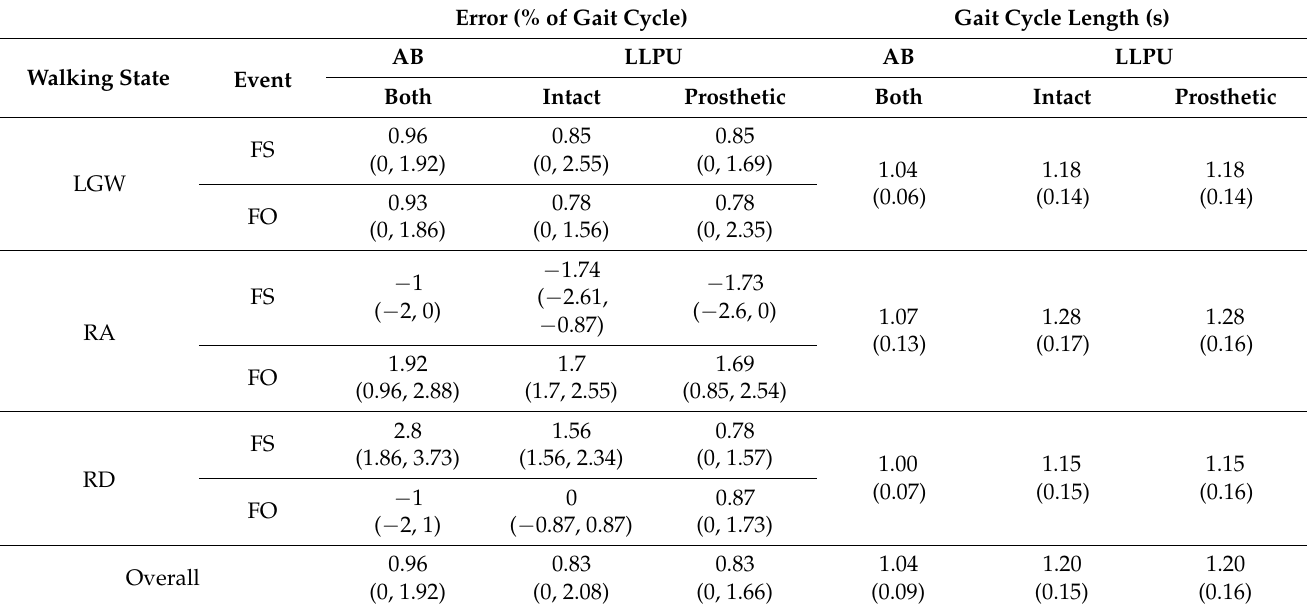
Table 4. Temporal error (median (IQR1, IQR3)) and corresponding gait cycle length (mean (standard deviation)) results of GED